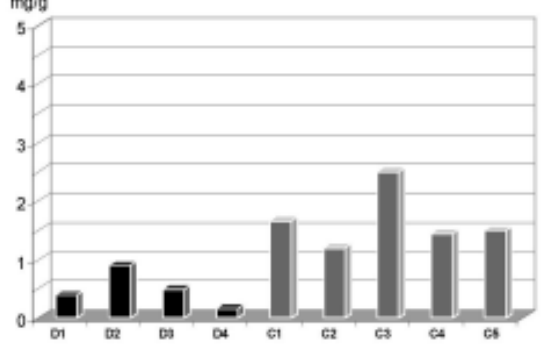
Fig. 6 - Quantificação de cálcio nas cúspides dos Heteroenxertos Descelularizados (D) e Homoenxertos Criopreservados (C). Demonstração gráfica do conteúdo de cálcio nas cúspides das valvas do Grupo Crio (C) e Grupo Desc (D), P=0,016